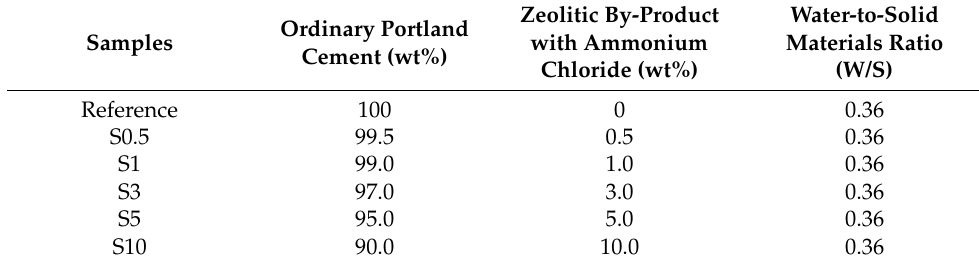
Table 2. Compositions of initial